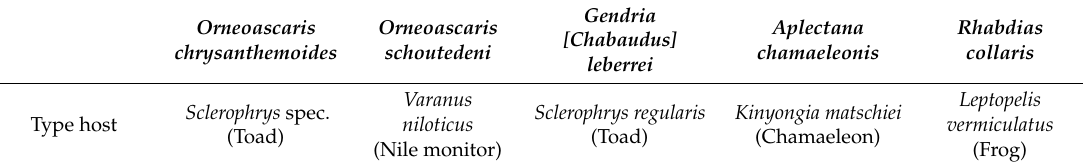
Table 5. Currently known amphibian and reptile host species of the parasitic nematodes detected in Hyperolius frogs. Hosts identified in this study are shown in bold